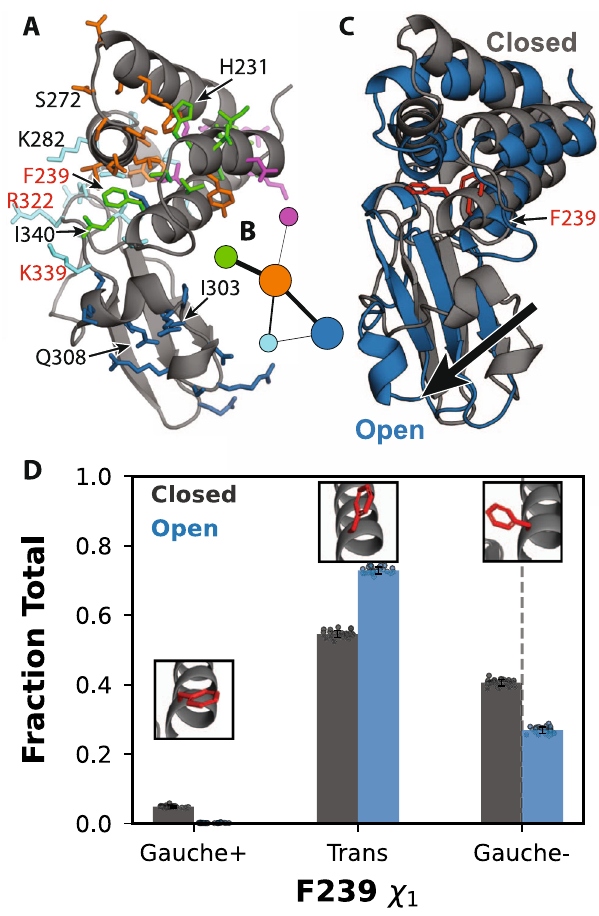
Fig. 3 Allosteric network revealed by the CARDS algorithm. A Structure of VP35 ’ s IID with residues in the allosteric network shown in sticks and colored according to which of fi ve communities they belong to. Substitution of residues labeled in red with alanine disrupts binding to dsRNA blunt ends and results in a dramatic reduction in immune suppression. B Network representation of the coupling between communities of residues, colored as in ( A ). Node size is proportional to the strength of coupling between residues in the community, and edge widths are proportional to the strength of coupling between the communities. C Representative states of the correlated changes from the DiffNet. In gray is a structure with a closed pocket and in blue is a structure from MD simulation with an open pocket. F239 is shown in red sticks for orientation. D Distribution of F239 χ 1 from the MSM with respect to states wherein the pocket is open (blue) or closed (black) for the three rotamers. The bar height is mean value from 25 bootstrapped MSMs (dots) of the sum of the population of all states in the MSMs with the speci fi ed rotamer. Insets show the conformation of F239 with the highest probability within the region of a given peak in the distribution as sampled in our MSM. The black dashed line at the Gauche position corresponds to the calculated value of F239 χ 1 from PDB 3L26. Error bars are standard deviation from the mean of bootstrapped values from recalculating the MSM twenty- fi ve times (see “ Methods ” ). Source data are provided as a Source Data fi